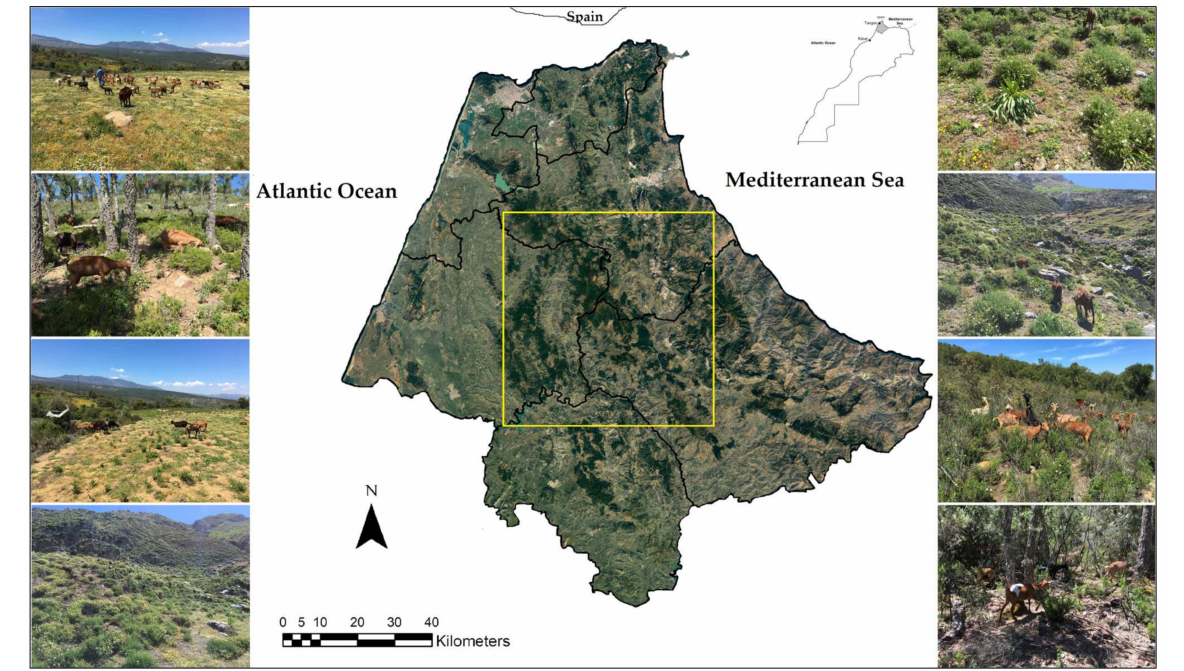
Figure 1. Map and photos of the studied forest rangelands in Northern Morocco. (Map was produced by Chebli in 2022 from the United States Geological Survey (USGS) archive).